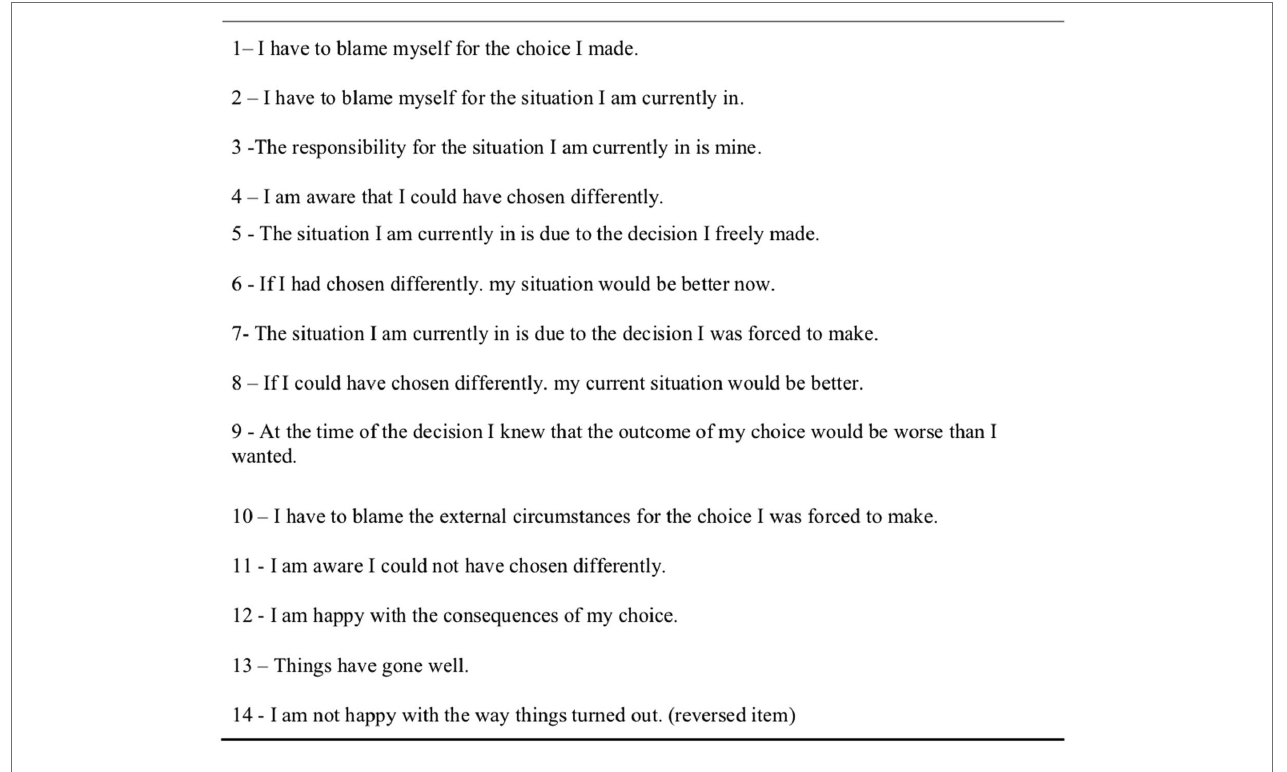
FIGURE 2 | Items of the phenomenology questionnaire.